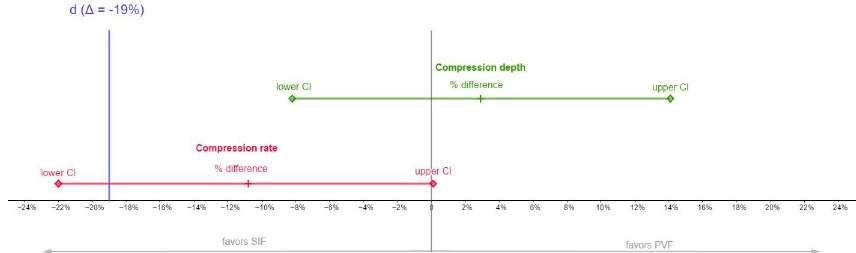
Fig 3. Non-inferiority results for compression depth and rate. Notes . Proportion (%) difference, lower and upper 95% CI for both compression rate and compression depth. The line marked “d” indicates the non-inferiority margin. Values < 0 favor SIF and values > 0 favor PVF. Significant non-inferiority is given when the lower CI lies above